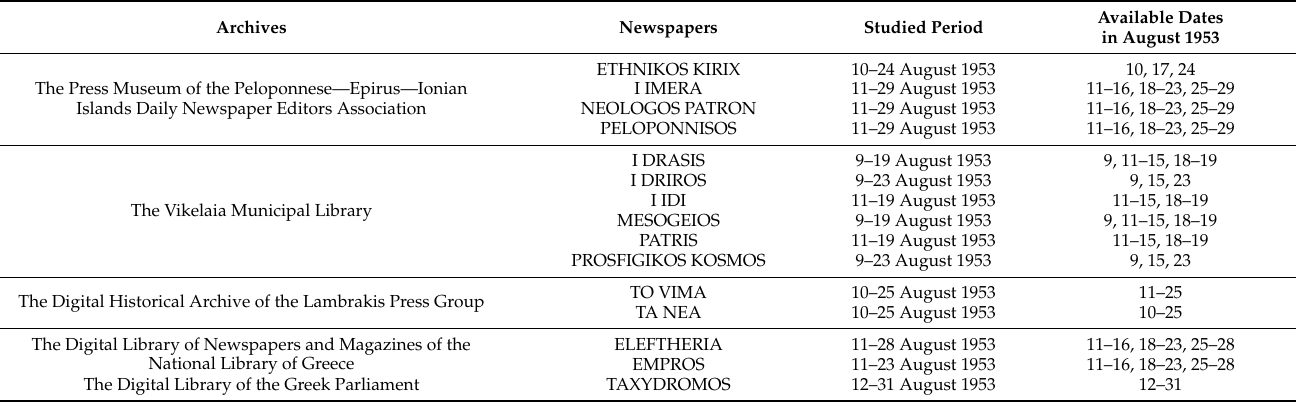
Table 1. Newspapers of local and national circulation used in this study for revisiting the 1953 Ionian Sea earthquake sequence and its primary and secondary environmental